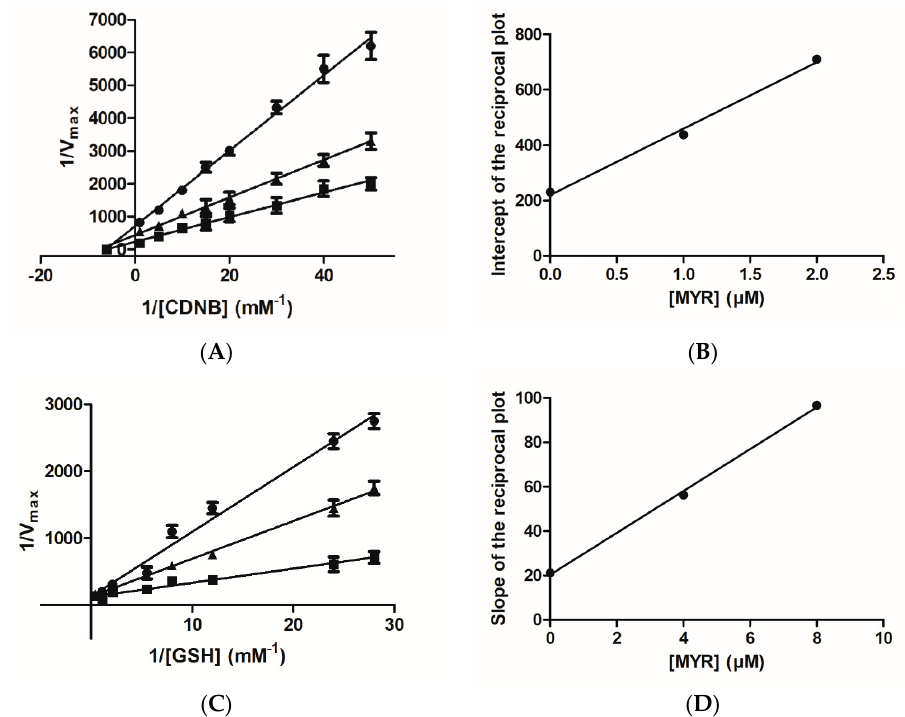
Figure 3. Lineweaver–Burk plots for the inhibition of hGSTA1–1 by MYR. ( A ) Inhibition of hGSTA1–1 by MYR (0 μ M ( ■ ), 1 μ M ( ▲ ), 2 μ M ( ● )) using the concentration of GSH constant and the concentration of CDNB varied (0.02–1 mM); ( B ) The dependence of the intercepts of the Lineweaver–Burk plots on MYR concentration. ( C ) Inhibition of hGSTA1–1 by MYR (0 μ M ( ■ ), 4 μ M( ▲ ), 8 μ M( ● )) using the concentration of CDNB constant and the concentration of GSH varied (0.035–2.5 mM). ( D ) The dependence of the slopes of the Lineweaver–Burk plots on MYR concentration.